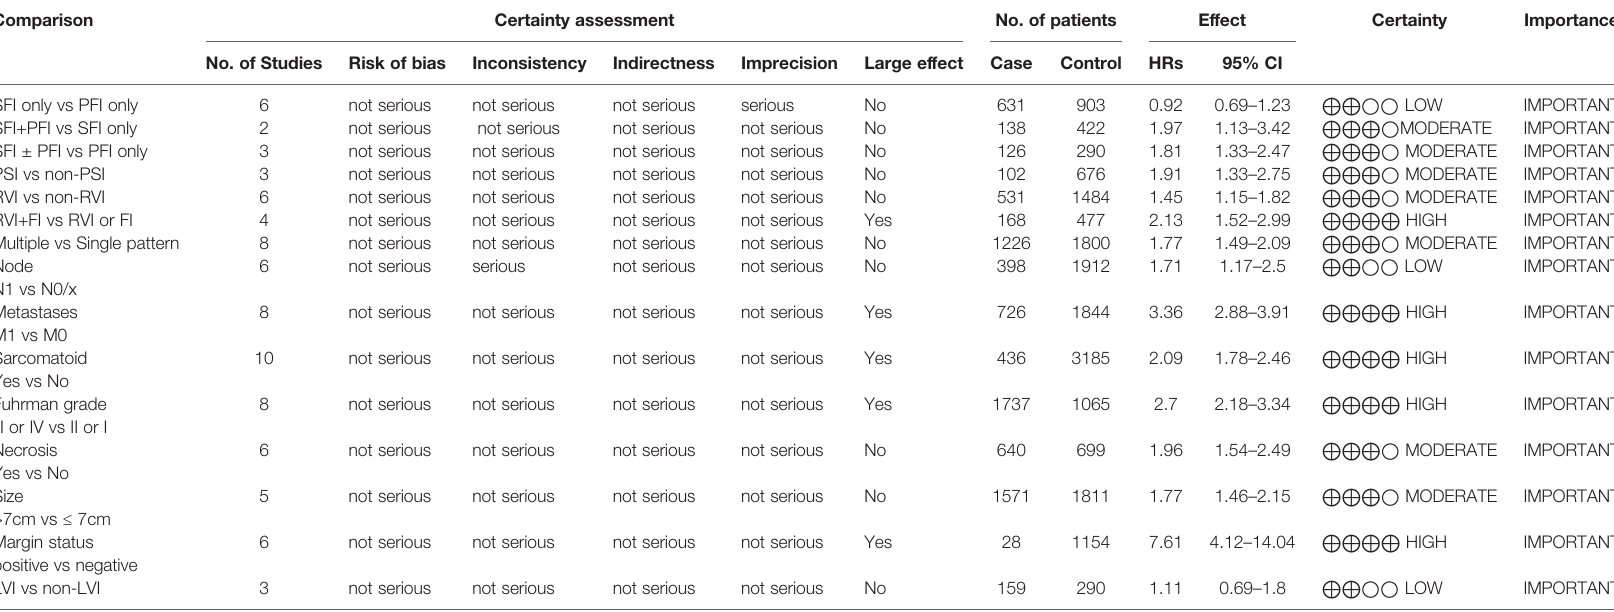
TABLE 3 | The overall quality of evidence according to the GRADE (Grading of Recommendations Assessment, Development, and Evaluation) approach.